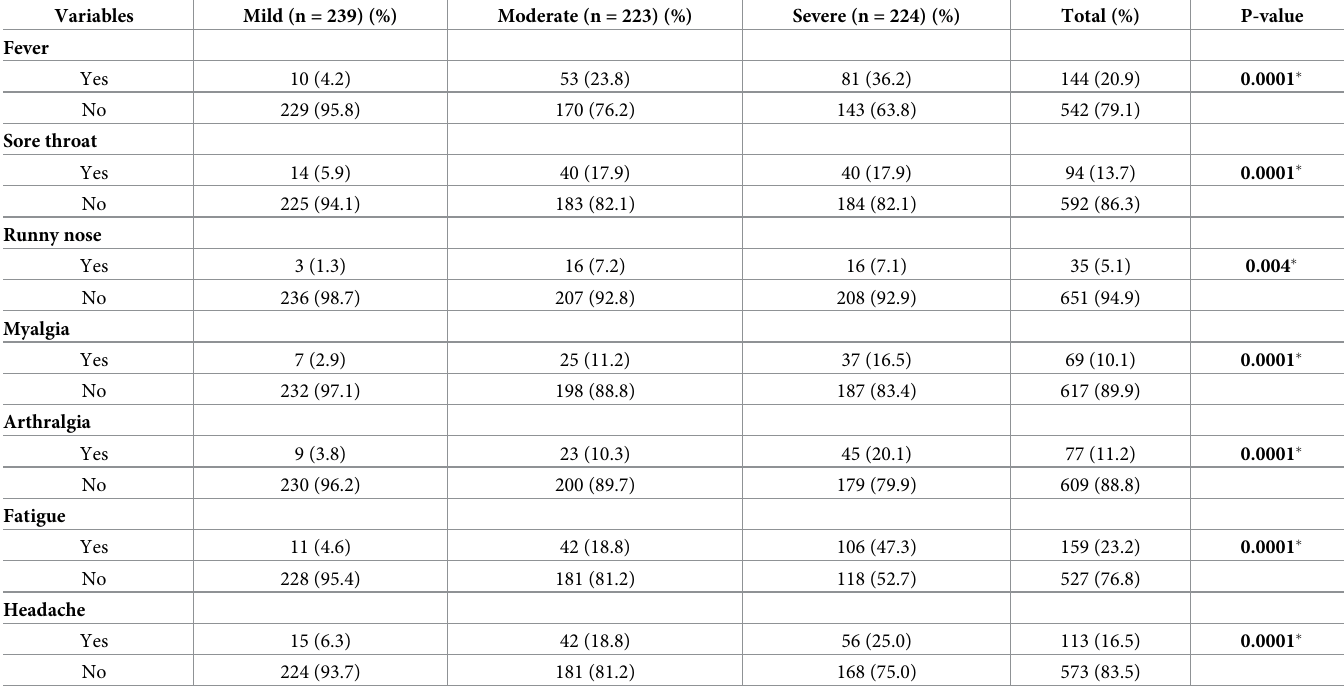
Table 2. Presenting symptom related characteristics and comparison based on disease severity among COVID-19 patients (n = 686).